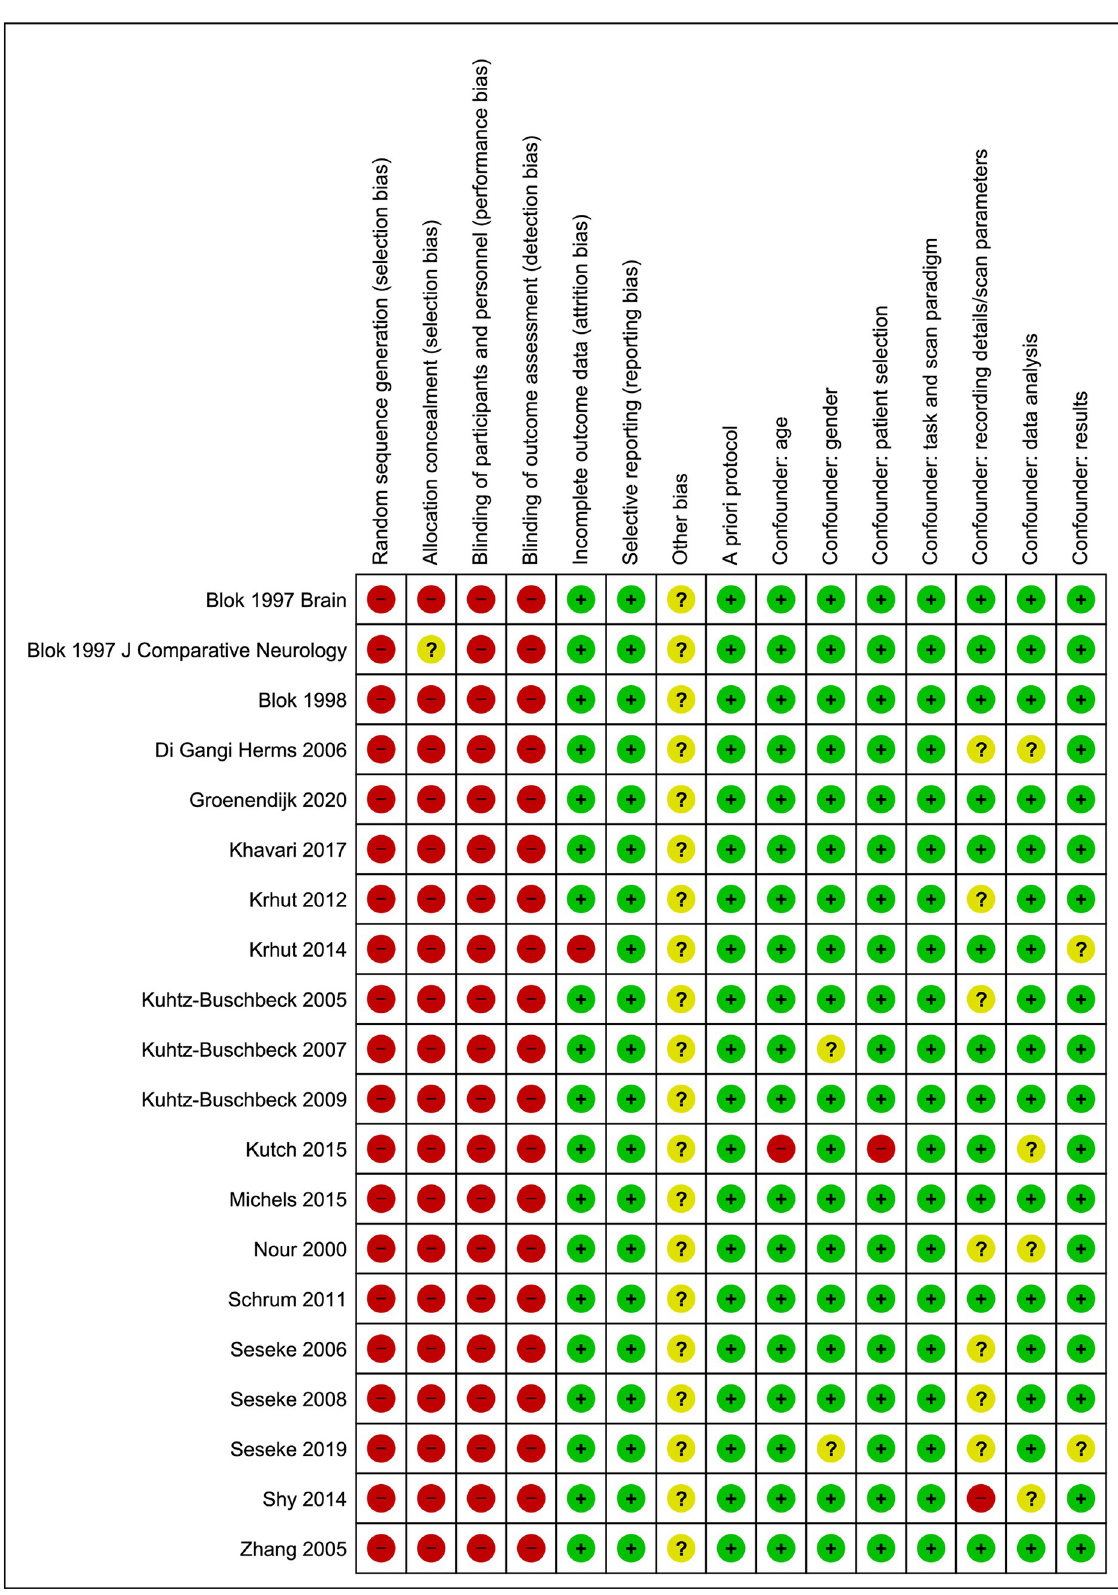
Fig 4. The results of the risk of bias assessment. https://doi.org/10.1371/journal.pone.0246042.g004 PLOS ONE | https://doi.org/10.1371/journal.pone.0246042 February 3,